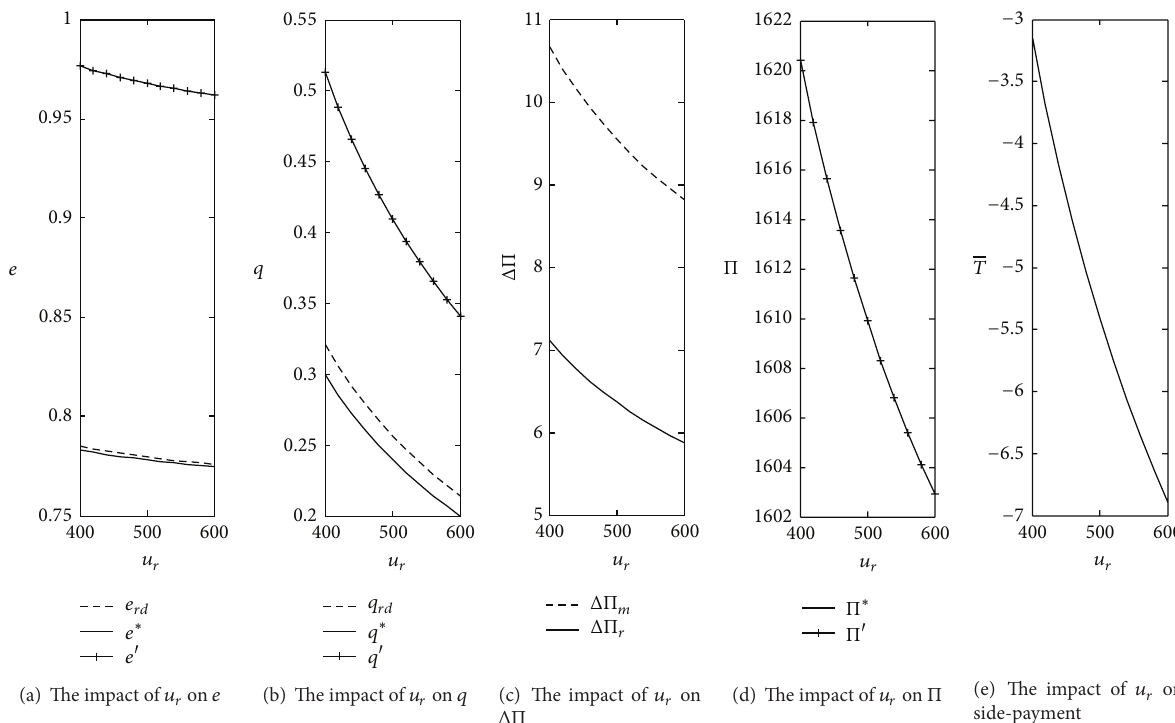
Figure 4: The impact of 𝑢 𝑟 on decision variables and